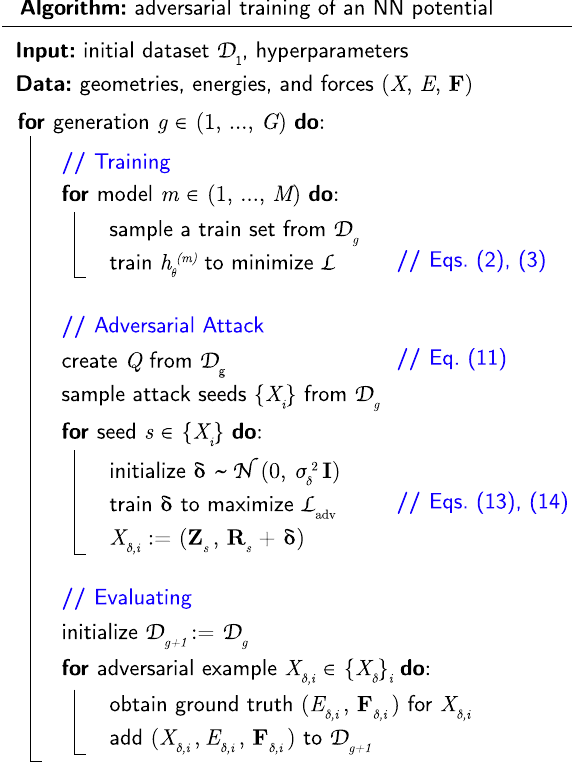
Fig. 2 Algorithm. Pseudocode of the adversarial training of a neural network